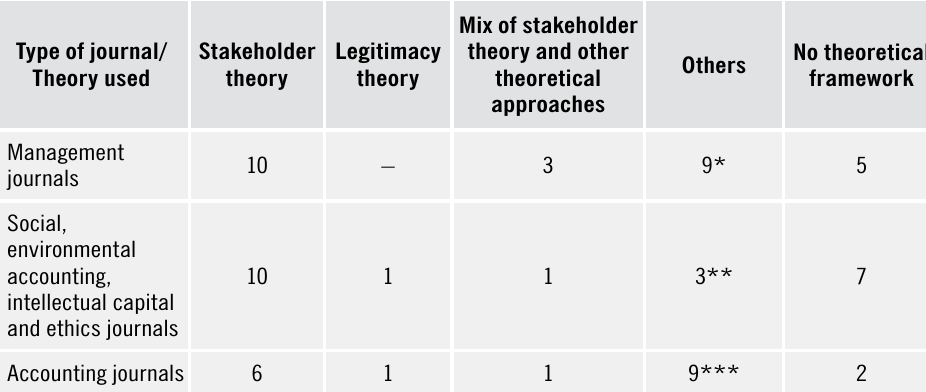
Table 1. Theoretical approaches identified in the analyzed